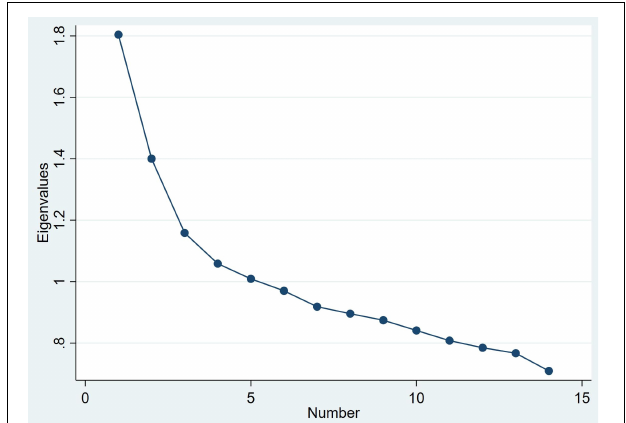
FIGURE 4 | Scree plot of eigenvalues for principal components of the Bush-Francis Catatonia Screening